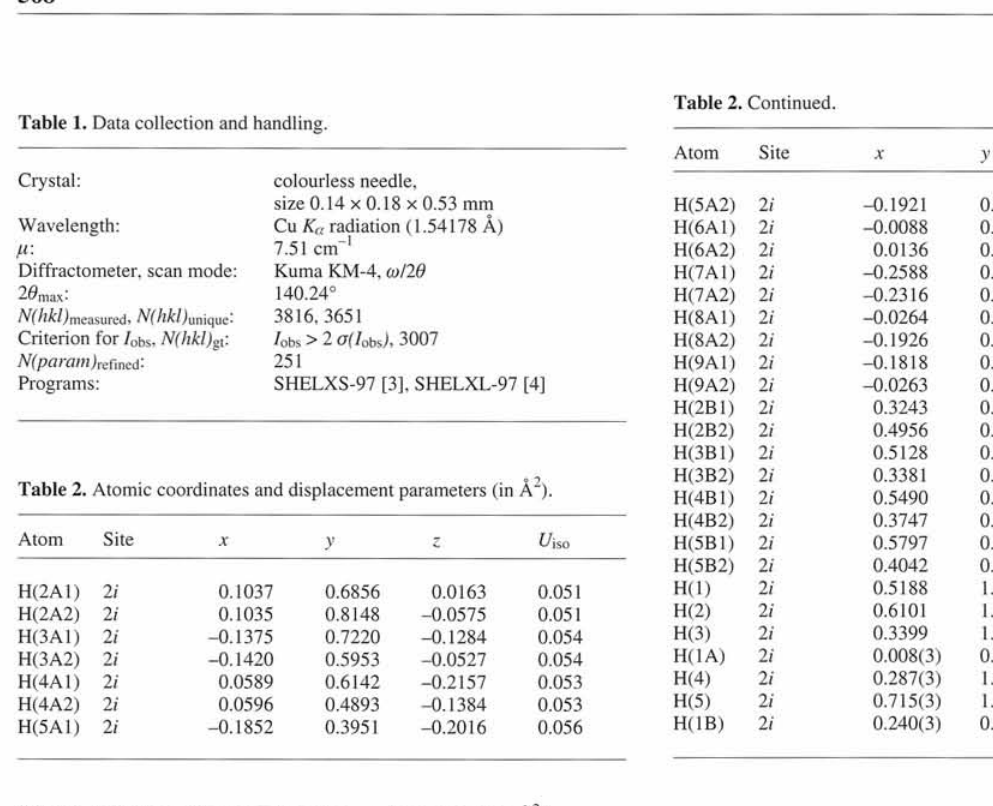
Table 3. Atomic coordinates and displacement parameters (in